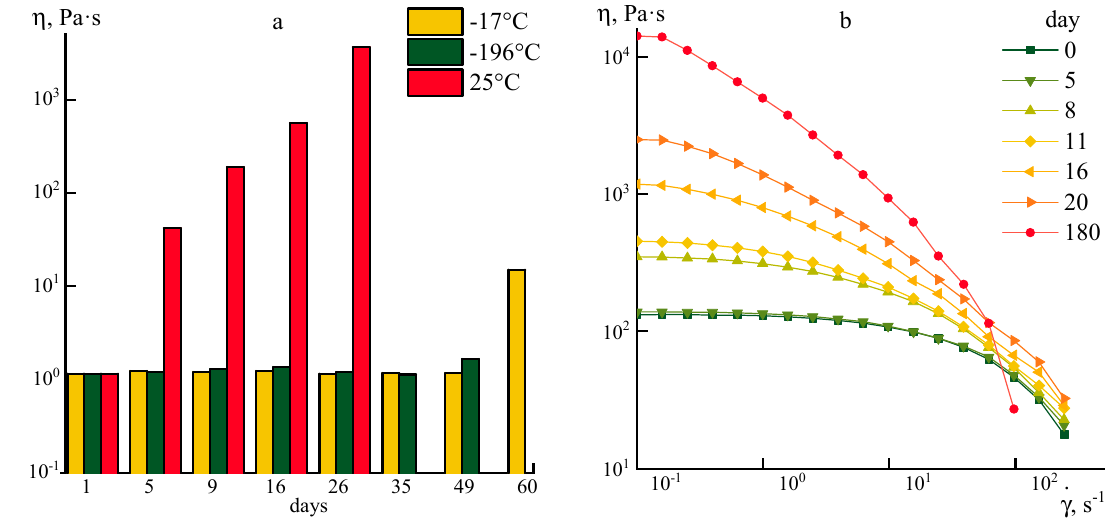
Figure 3. ( a ) Changes in the maximal Newtonian viscosity measured at 25 °C for P2 solution stored over prolong time at different temperatures, and ( b ) flow curves of 10% P1 solutions stored at 25 °C, over time.